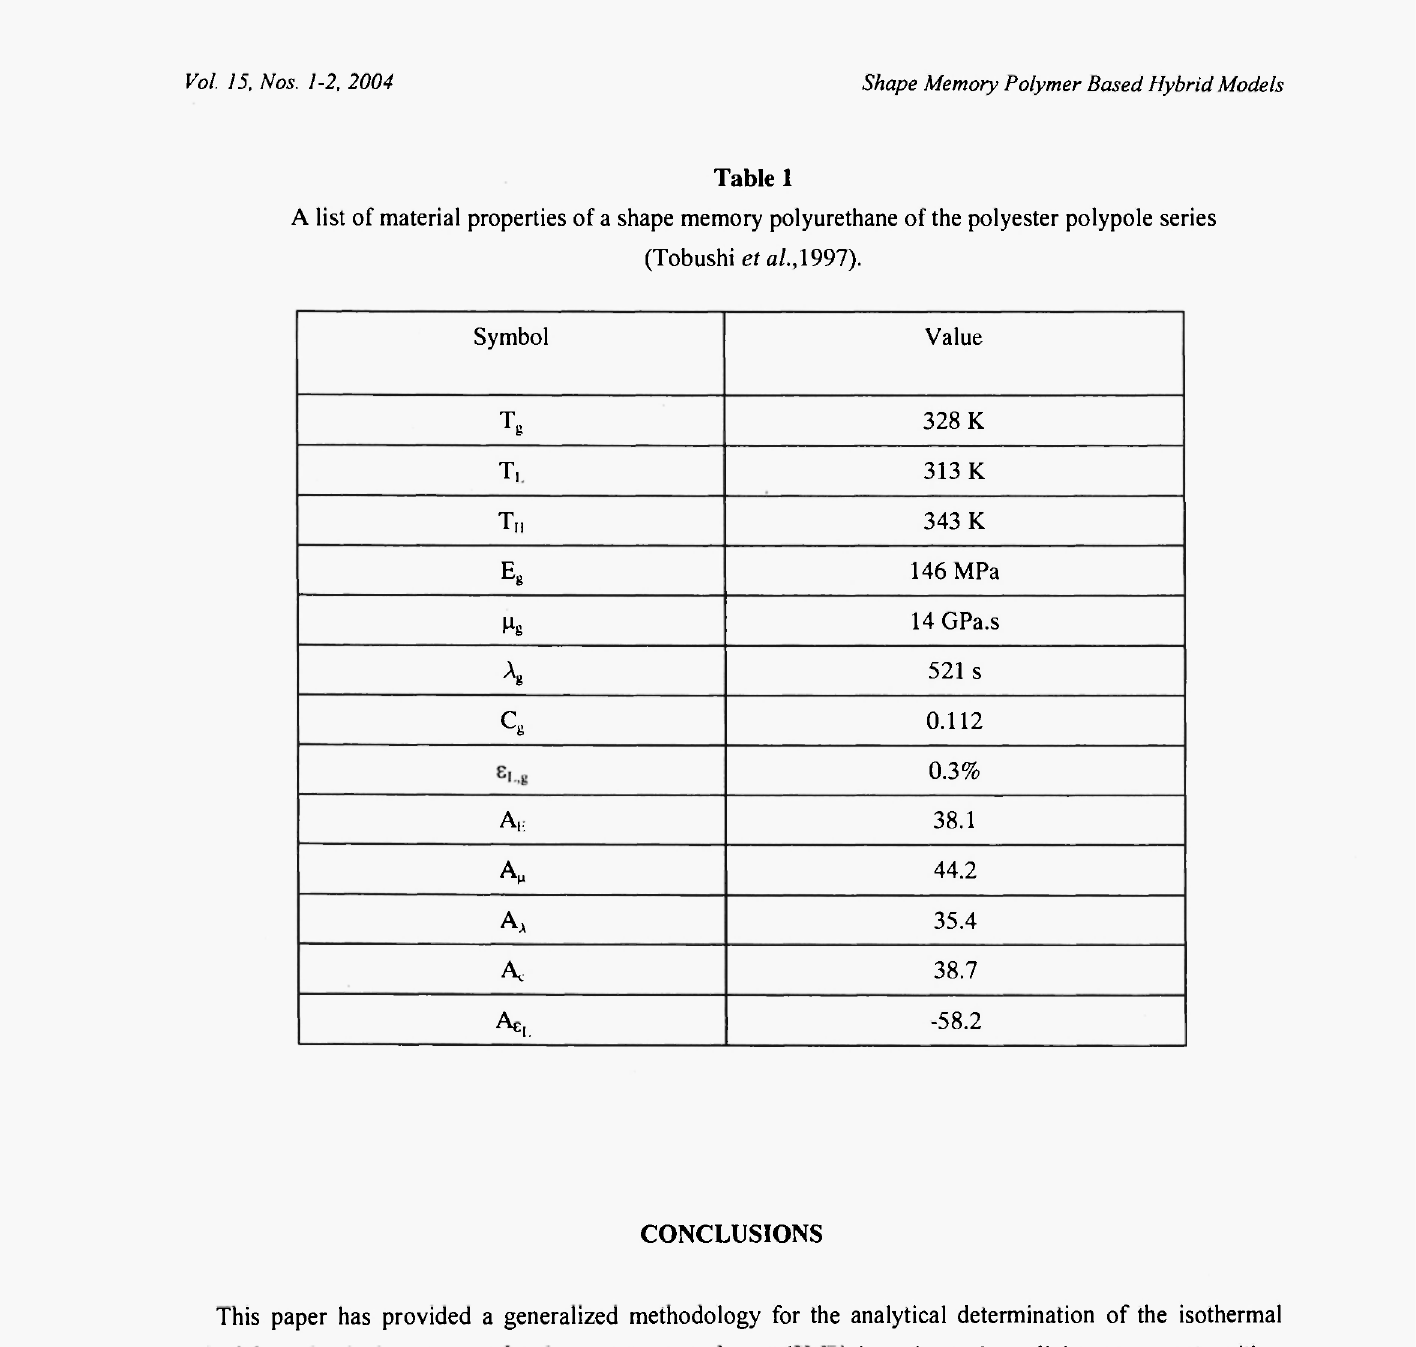
A list of material properties of a shape memory polyurethane of the polyester polypole series (Tobushi et α/.,